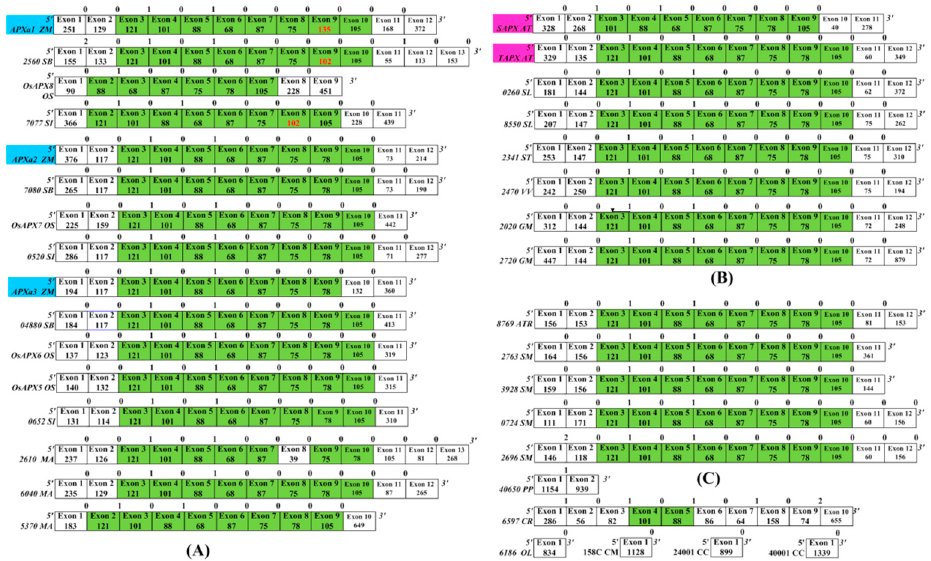
Figure 2. Exon/intron structures of APX genes of class A. ( A ) Exon/intron structures of APX genes of class A of monocotyledon. ( B ) Exon/intron structures of APX genes of class A of dicotyledon. ( C ) Exon/intron structures of APX genes of class A of the species except for monocotyledon and dicotyledon. The intron phases are shown on top of each exon boundary. Exon sizes are not drawn to scale. Green columns indicate highly similar exons of the same size among different species. ZM, Zea